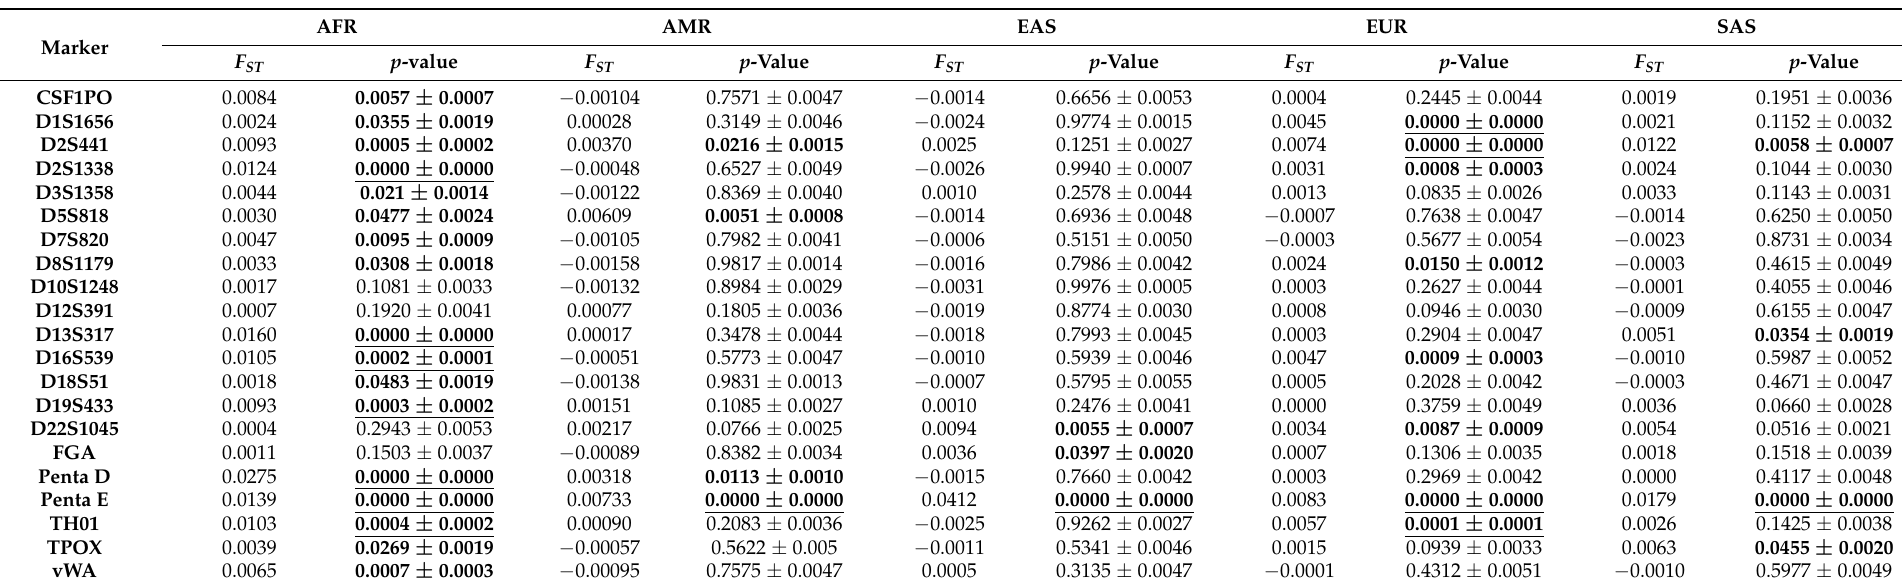
Table 4. F ST and probabilities of population non-differentiation comparing population groups of the 1000 Genomes Project to those of the SPSmart STR browser (PopSTR) for each STR marker. Significant p -values ( α = 0.05) are in boldface. The probabilities that remained significant after the Bonferroni correction for